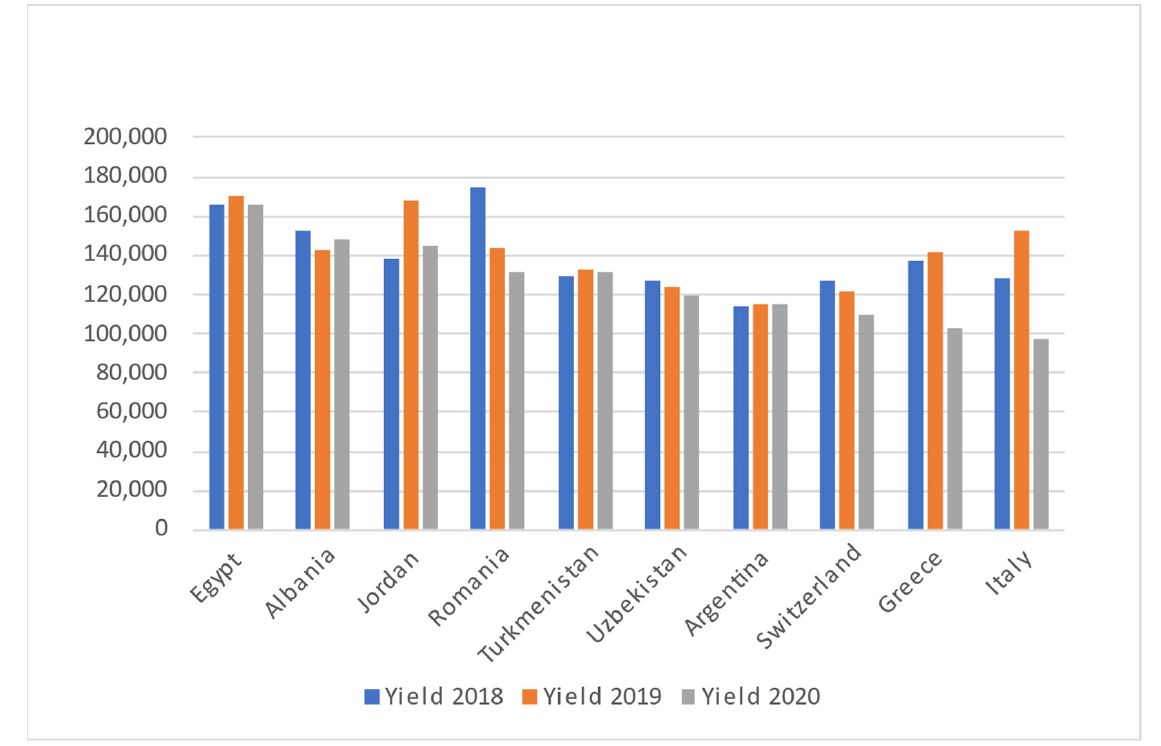
Figure 2. Yield of apricot for the top 10 Countries in the years 2018, 2019 and 2020.